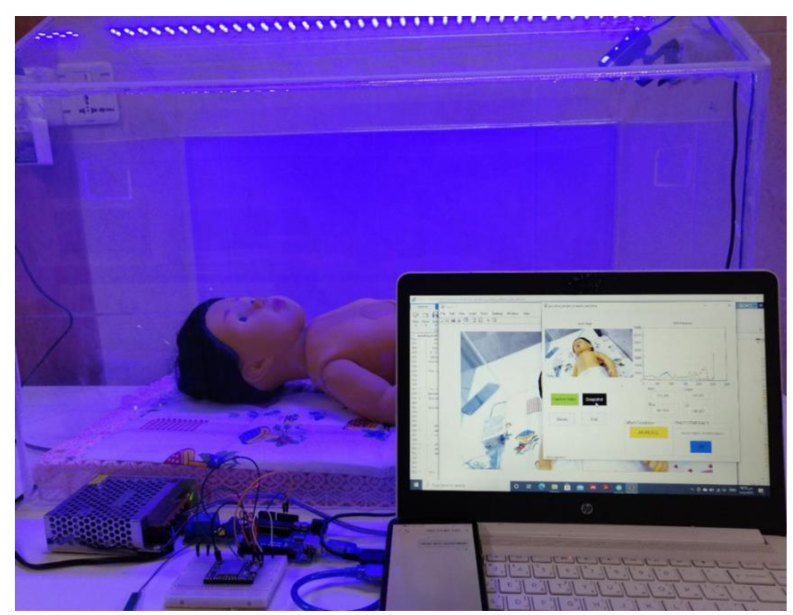
Figure 7. The blue LED inside the incubator is switched ON when jaundice is detected.